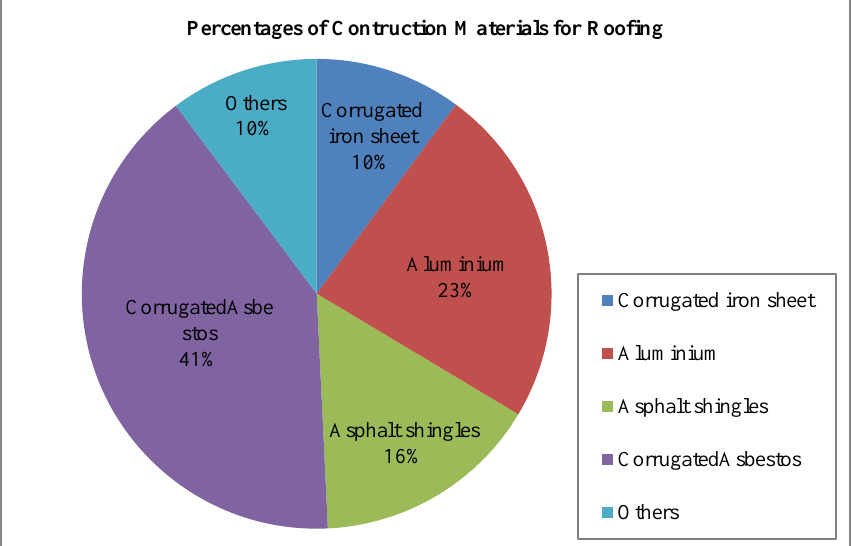
Figure 6. Percentages of Construction Materials for